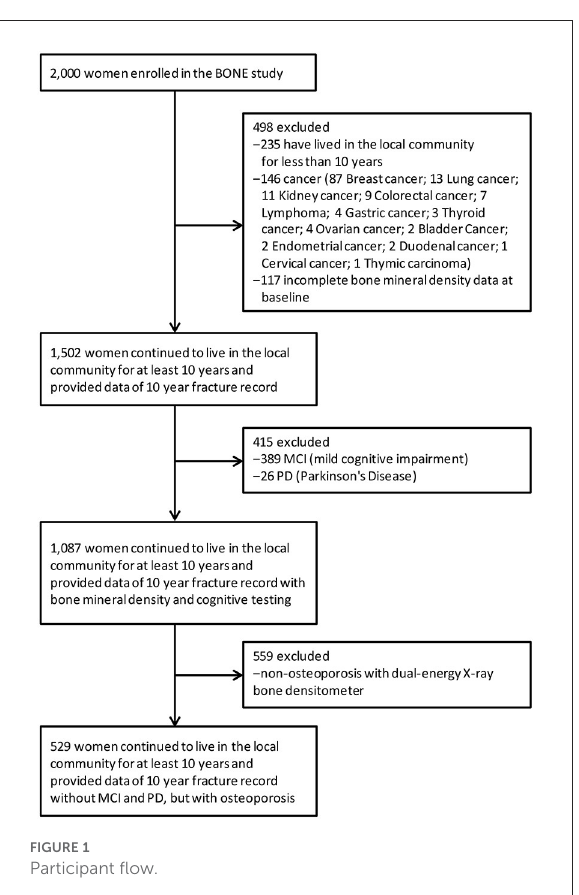
FIGURE1 Participant